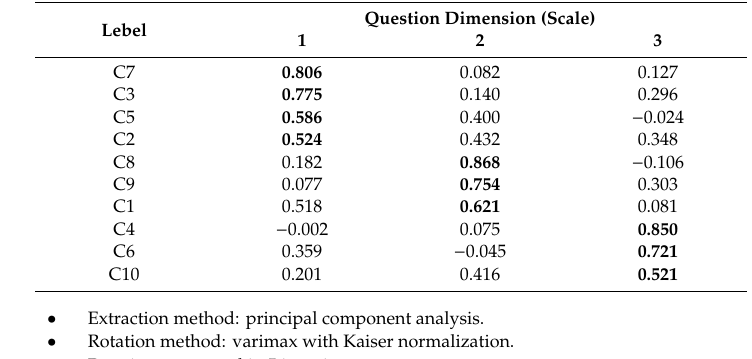
Table A5. Rotated component matrix.